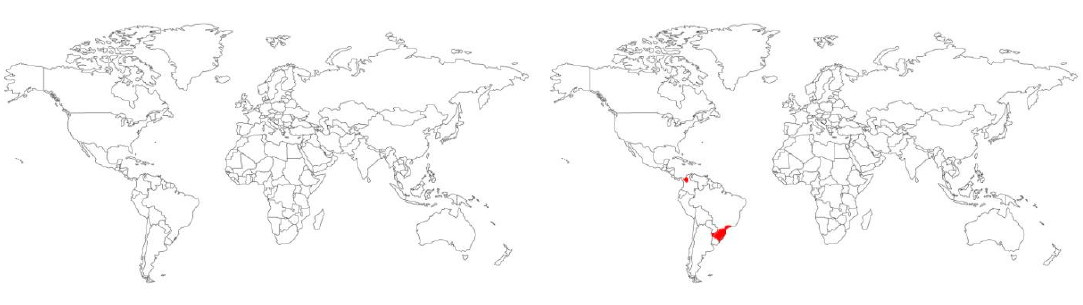
Figure 2. The occurrence of pathogenic tick-borne species belonging to the genus Rickettsia in the world at the beginning of the 21st century compared to now. On the left—the state of knowledge in 2005. On the right—the state of knowledge in 2019 [1,4,17–31,33,35,36,38,39,41–47,56,98–122].